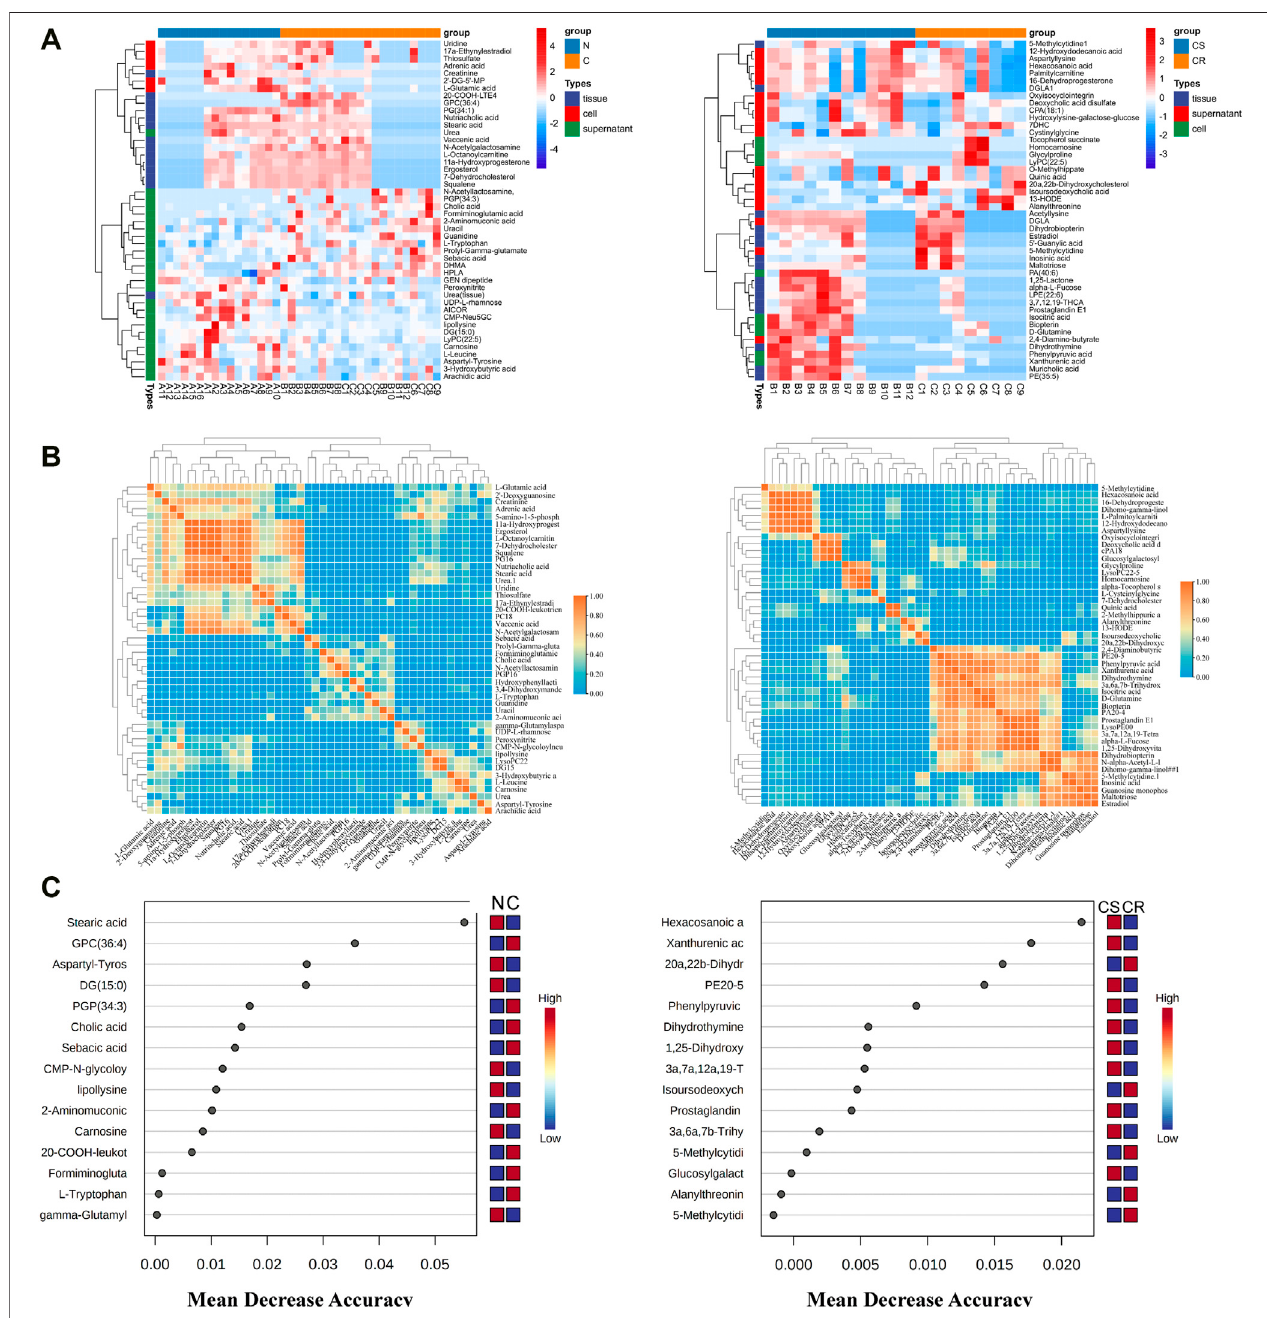
FIGURE 2 | Metabolites Characteristics of ascites supernatant, precipitated cells and tissues in ovarian cancer. (A) Results of hierarchical cluster analysis of metabolites of ascites supernatant, precipitated cells and cancer tissue in ovarian cancer. Each row represents a metabolite, and each column represents a different group. (B) CorrelationheatmapofdifferentialmetabolitesinNvsC (left) andCSvsCR (right) . (C) RandomforestsshowimportantdifferentialmetabolitesinNvsC (left) and CS and CR (right) . N: non-chemotherapy group, C: chemotherapy group; CS: chemotherapy-sensitive group; CR: chemotherapy-resistant group.